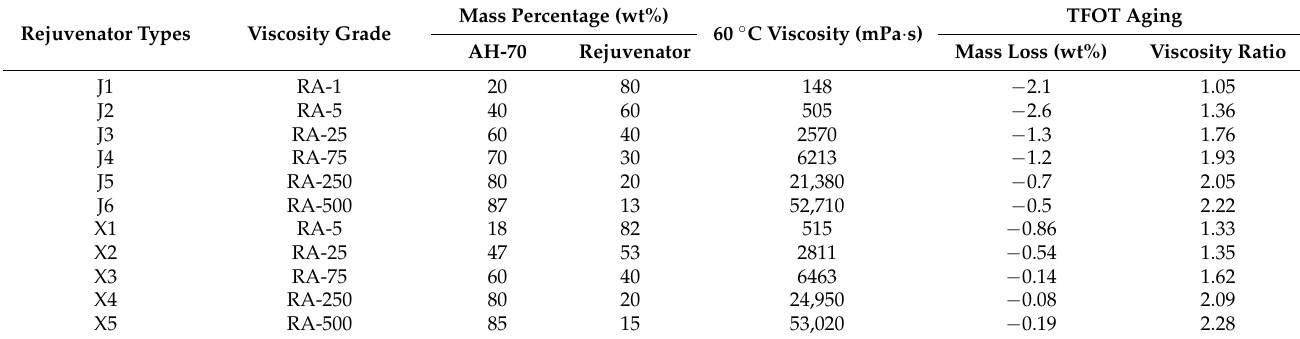
Table 5. The properties of different compound rejuvenators.